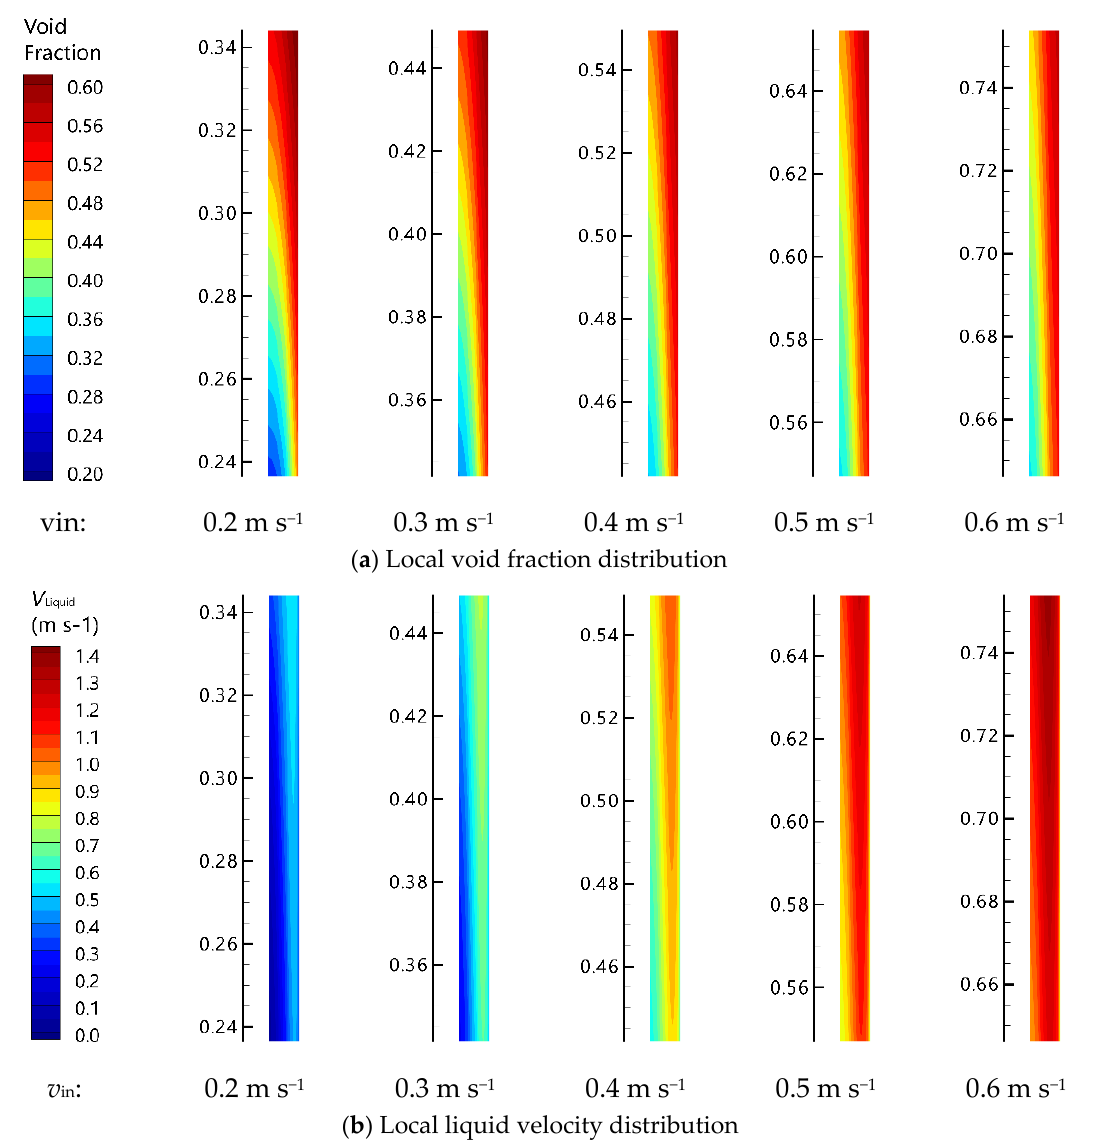
heated wall on the right, with the z -axis scale in m.